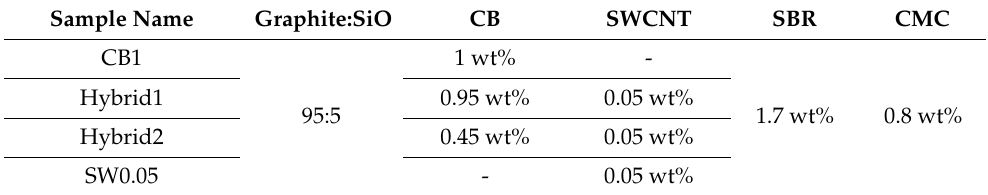
Table 1. Electrode compositions of four